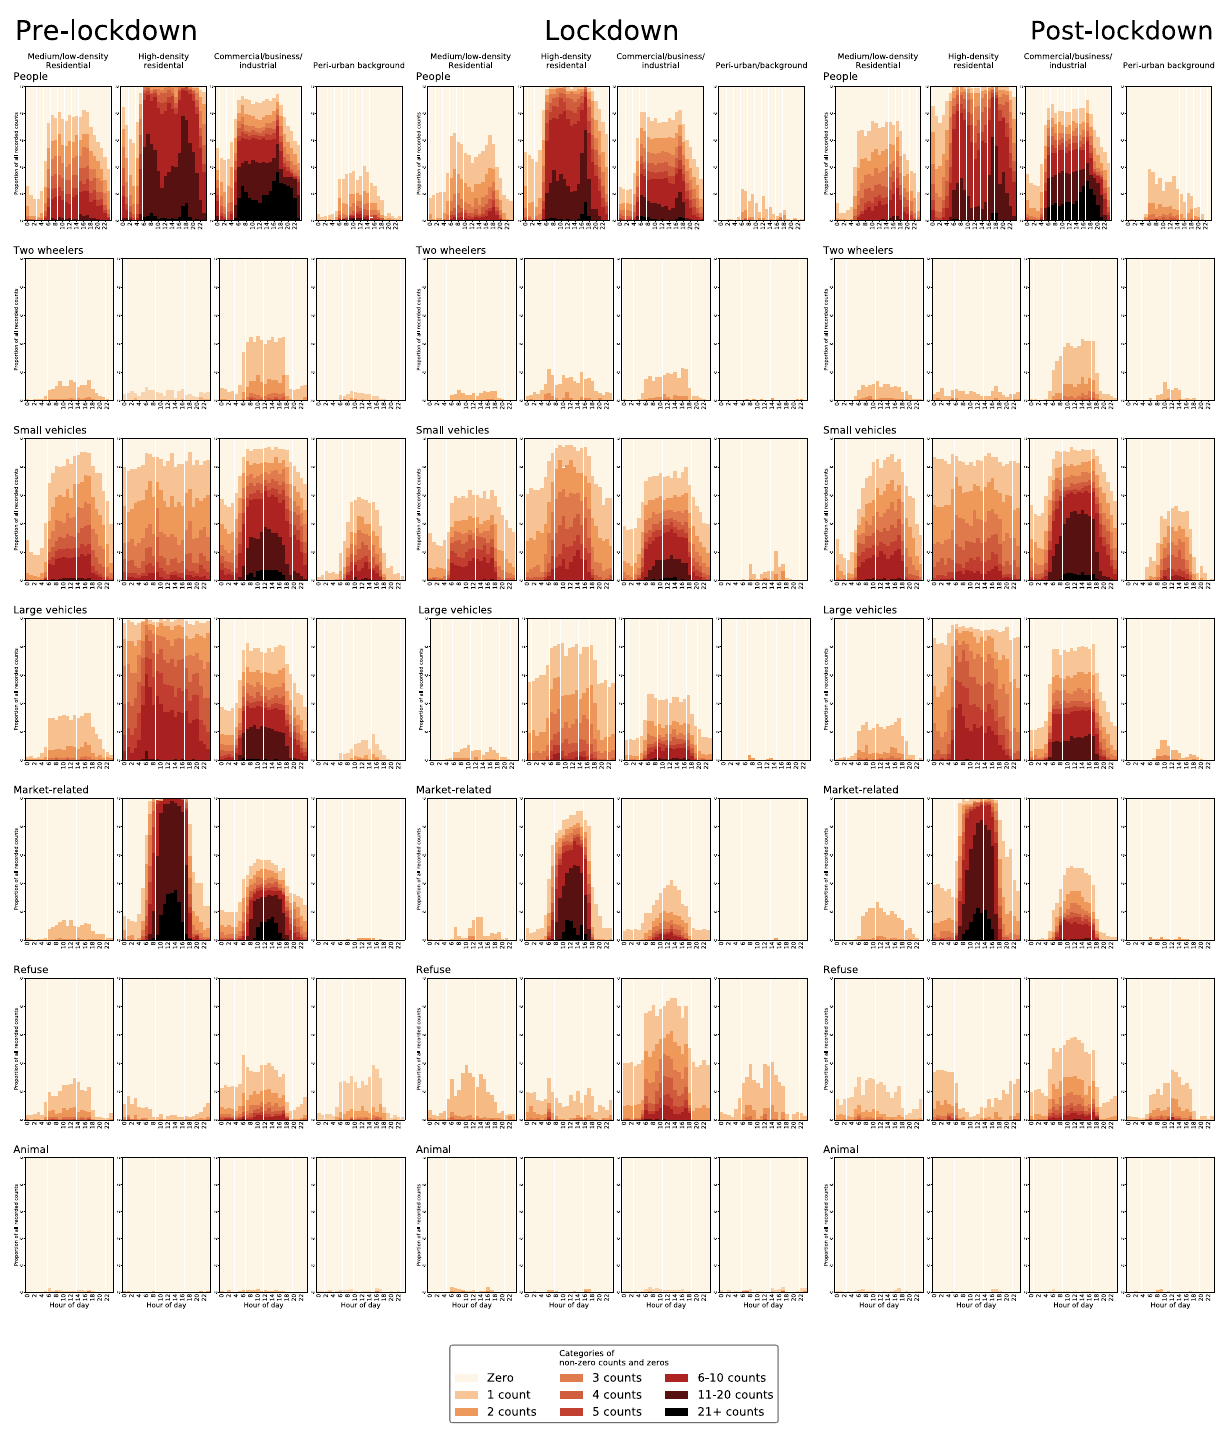
Figure 7. Comparison of object counts before, during and after lockdown. The data are from the eight of the ten fixed sites, which had some data during the city-wide lockdown from the 30th of March to the 20th of April 2020 in response to the COVID-19 pandemic. Pre-lock down refers to the period from the 10th April 2019 to the 29th of March 2020, and post-lockdown from the 21st of April to the 11th June